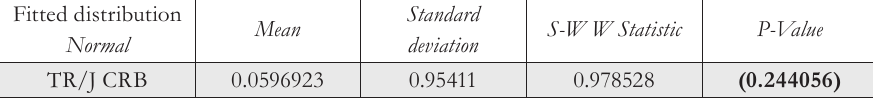
Tab. 1 – The Shapiro-Wilk test. Source: Own calculations in Statgraphics Centurion. Fitted distribution Standard Mean S-W W Normal deviation